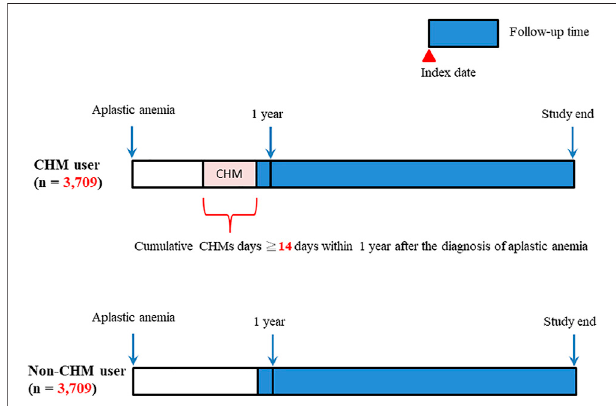
FIGURE 2 | Diagram of follow-up time for AA patients. Abbreviations: AA, aplastic anemia.